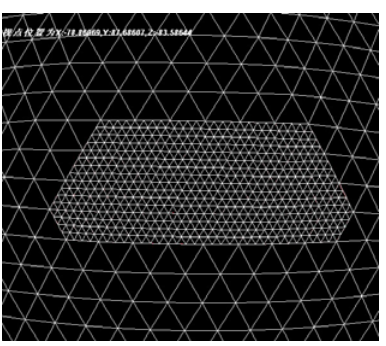
Figure 8 the partition of Multi-Resolution LOD based on